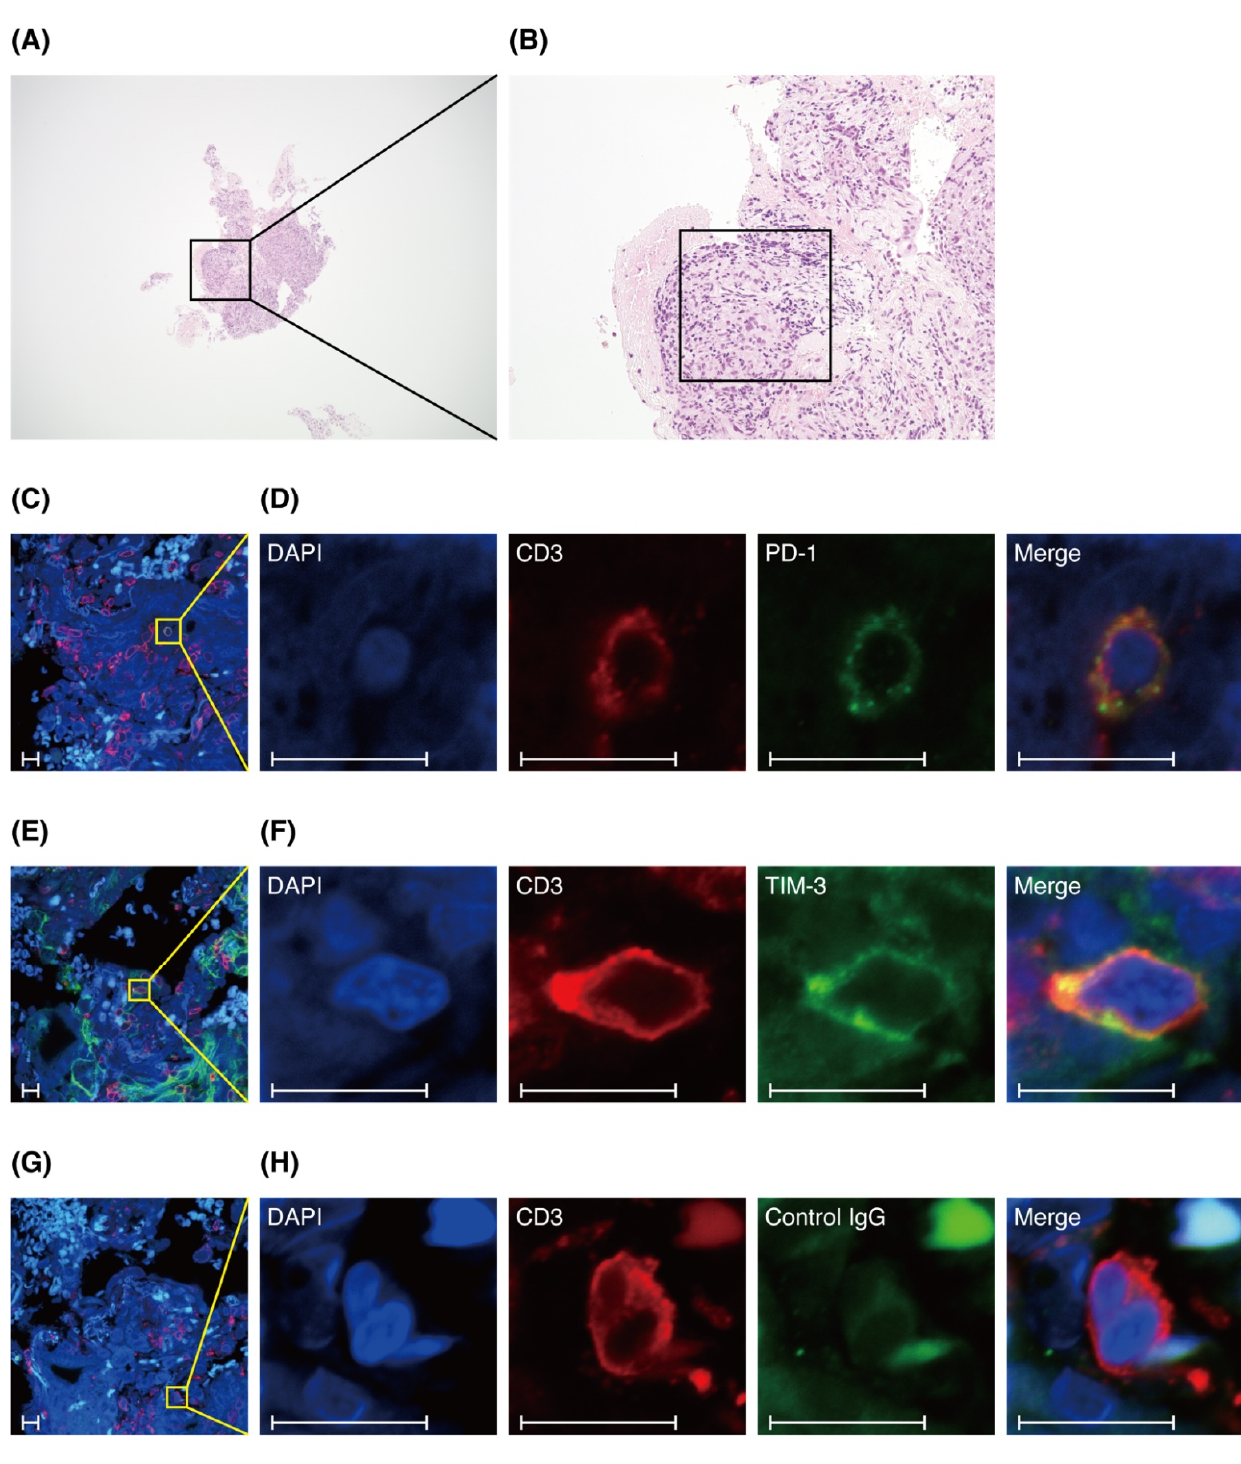
Figure 4. Programmed cell death 1 (PD-1) and T-cell immunoglobulin- and mucin-domain-containing molecule-3 (TIM-3) expression on CD3 + T cells in lung specimens. Hematoxylin–eosin (HE) stained 4× image ( A ) and 20× image ( B ). The square in ( B ) indicates the location of the immunofluorescence staining analysis. ( C – H ) Immunofluorescence staining of DAPI (blue), CD3 (red), PD-1 (green), TIM-3 (green), and Control IgG (green). ( C , E , G ) Images of 40×. ( D , F , H ) crop figures, respectively. Scale bars: 10 μm.